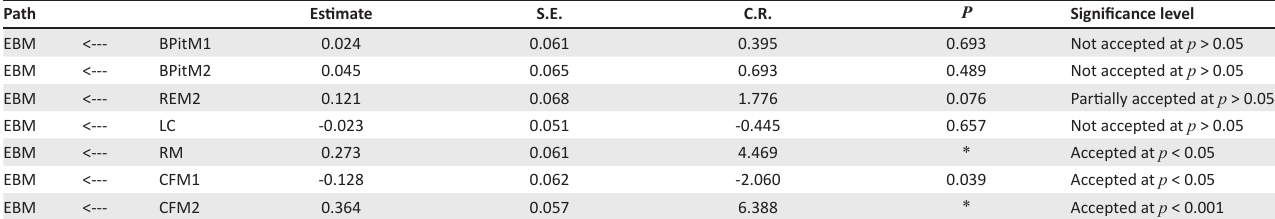
TABLE 7: Regression weights of the independent and dependent variables. Path